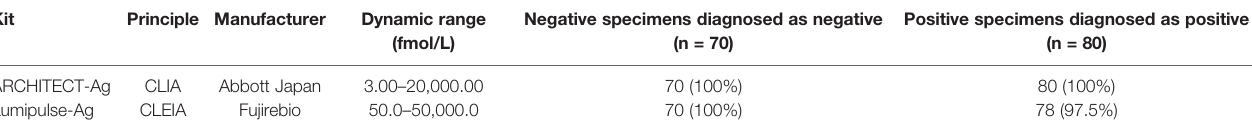
TABLE 5 | Detection of HCV Ag in regional reference panels by HCV Ag quanti fi cation kits.